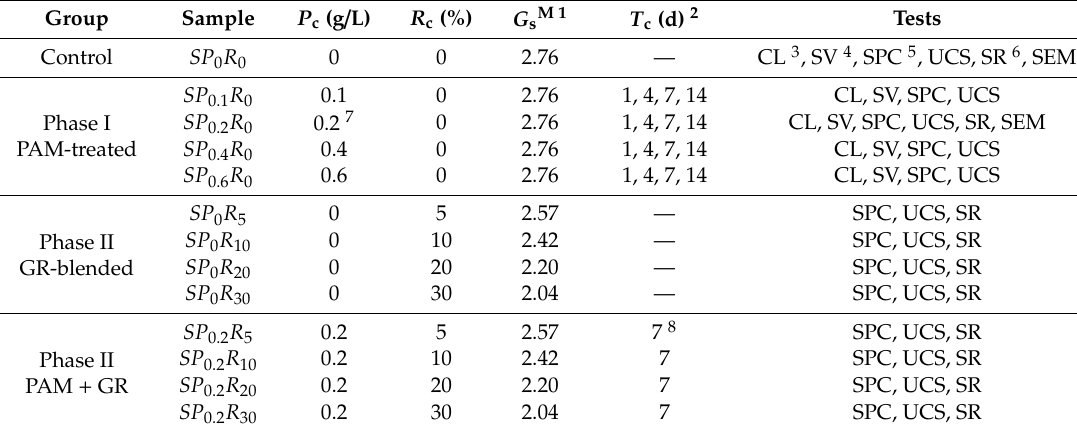
Table 3. Soil–PAM–GR mix designs and their